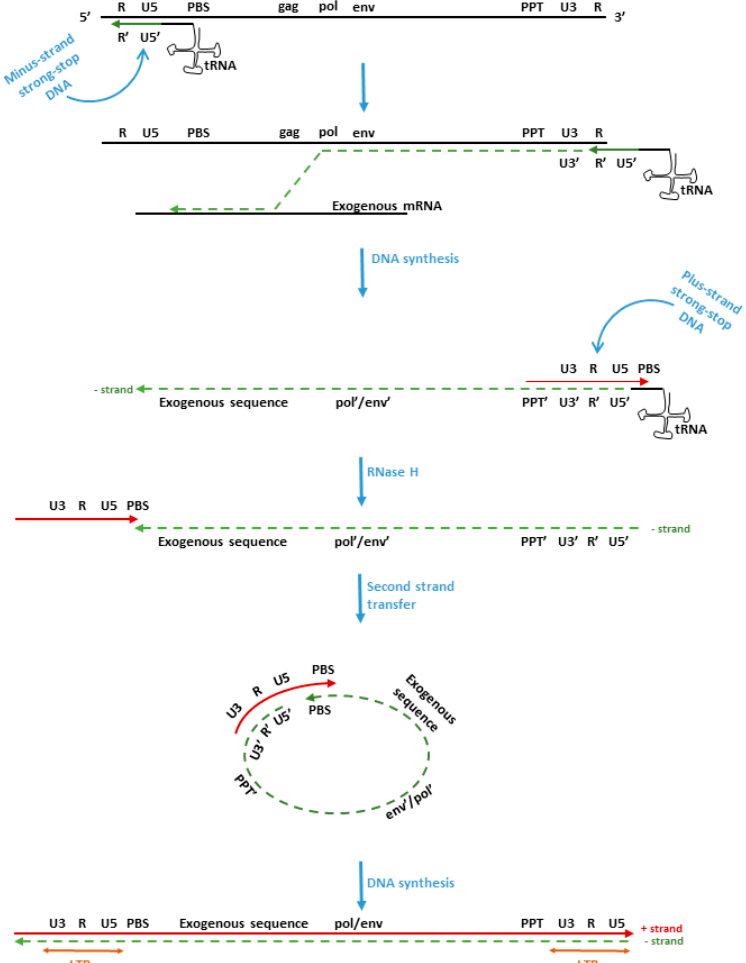
Figure 1. Process of reverse transcription of retroviral DNA: RNA = thin black line, hyphen-line = minus ( − ) strand DNA, bold, dark color = plus (+) strand DNA. PPT, polyuridine tract, which is resistant to RNase H degradation. PBS, primer binding site; RNase H, ribonuclease H, an enzyme specific for RNA strand: DNA duplexes. During the synthesis of minus ( − ) strand DNA (dashed-line) there is a possibility of nonhomologous recombination.